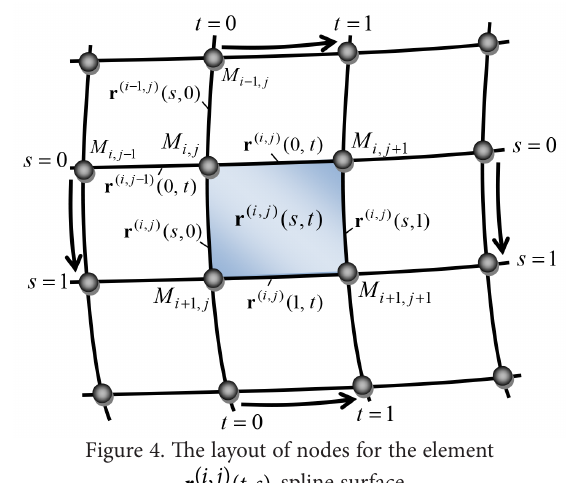
Figure 4. The layout of nodes for the element ( , ) ( , ) i j t s r spline